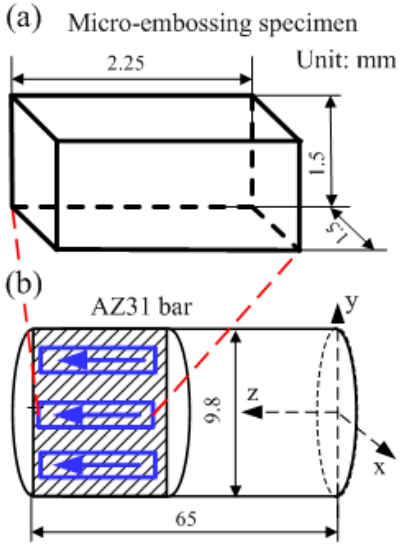
Figure 2. Schematic illustration of specimen preparation by using a CNC milling machine: ( a ) the geometry of the micro-embossing sample; ( b ) the sample cutting section and direction.